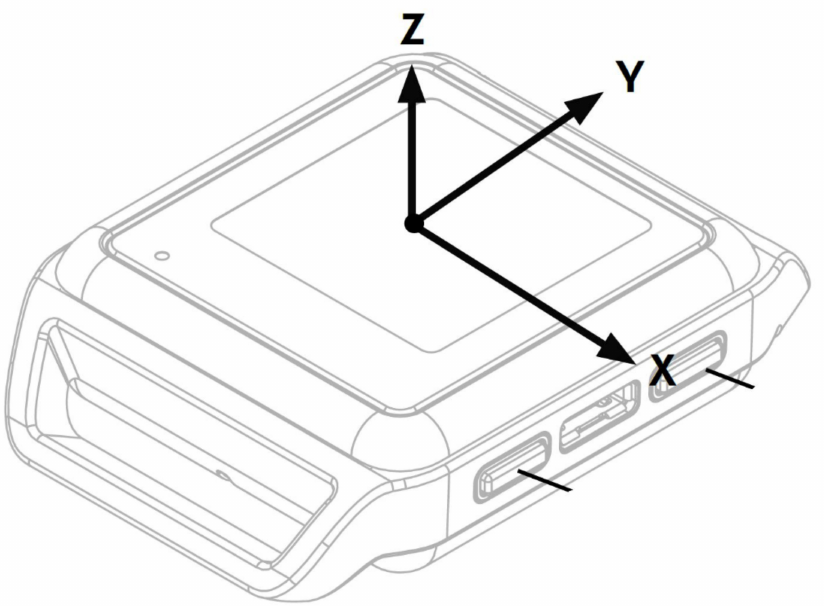
Figure 2. Opal Sensor with the illustration of the x -axis, y -axis and z